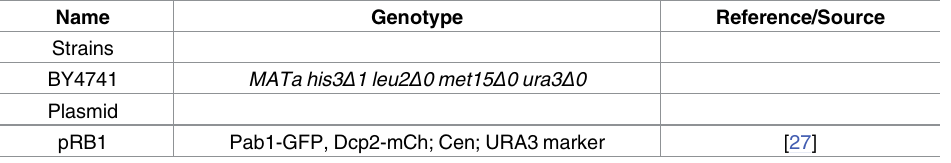
Table 3. Strains and plasmids used in this